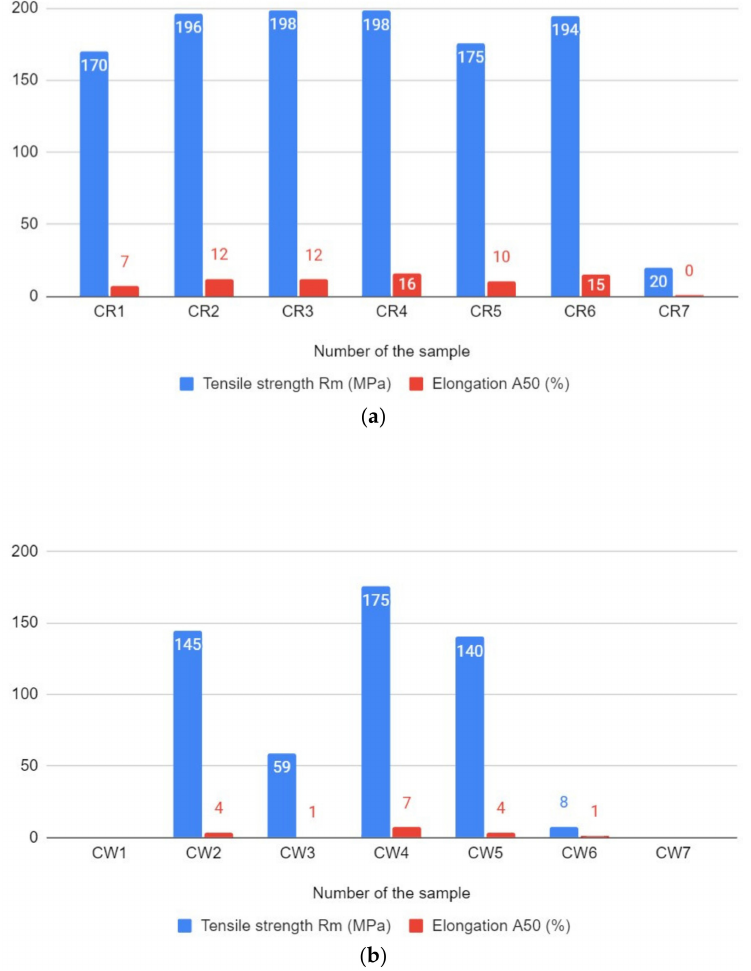
Figure 7. The graphs of tensile strength and elongation results depending on: ( a ) the welding speed; ( b ) the rotational speed.